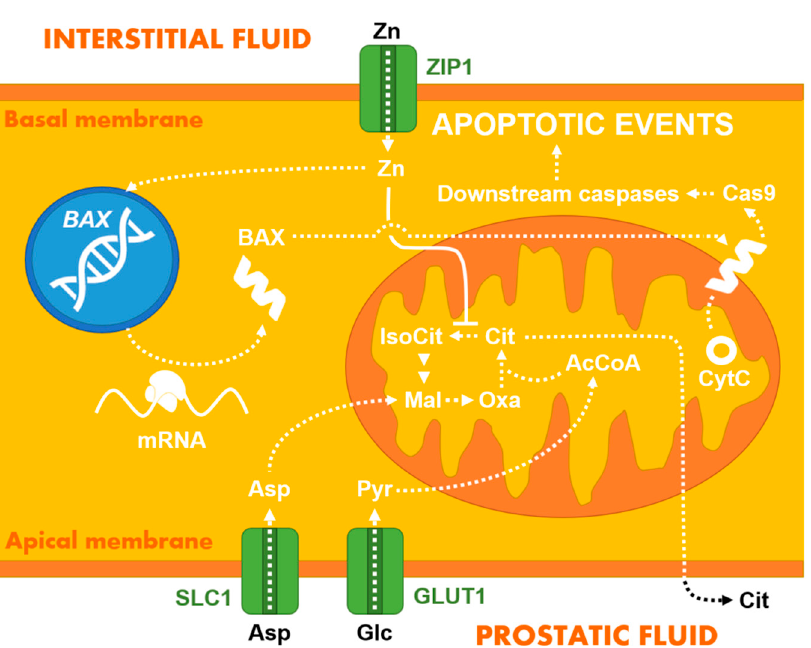
Figure 3. Zinc regulating citrate levels and apoptotic events in PCa. Schematic presentation of a prostate epithelial cell introducing different roles of zinc ions in regulation of citrate levels in a prostatic fluid and even controlling apoptotic events in PCa tissues. In PCa, while the levels of Zn are decreased, Zn ions no longer inhibit aconitase enzyme in the Krebs cycle, so the cycle proceeds further and the cell gains energy necessary e.g., for proliferation. As a result, levels of citrate in PCa decrease in a prostatic fluid. Interstitial fluid is also depicted, as a rich source of low molecular mass Zn-ligands (Zn-citrate, Zn-aspartate, Zn-histidine, etc.). Abbreviations: ZIP1—Zinc transporter, SLC1—Membrane transport protein for some amino acids, GLUT1—Glucose transporter, Asp—Aspartate, Glc—Glucose, Pyr—Pyruvate, AcCoA—Acetyl-CoA, Mal—Malate, Oxa—Oxalacetate, Cit—Citrate, IsoCit—Isocitrate, CytC—Cytochrome C, Cas9—Caspase 9, BAX (product of a BAX gene)—apoptosis regulator bcl-2-like protein 4. Image redrawn from ref. [23]. Copyright (2016) with